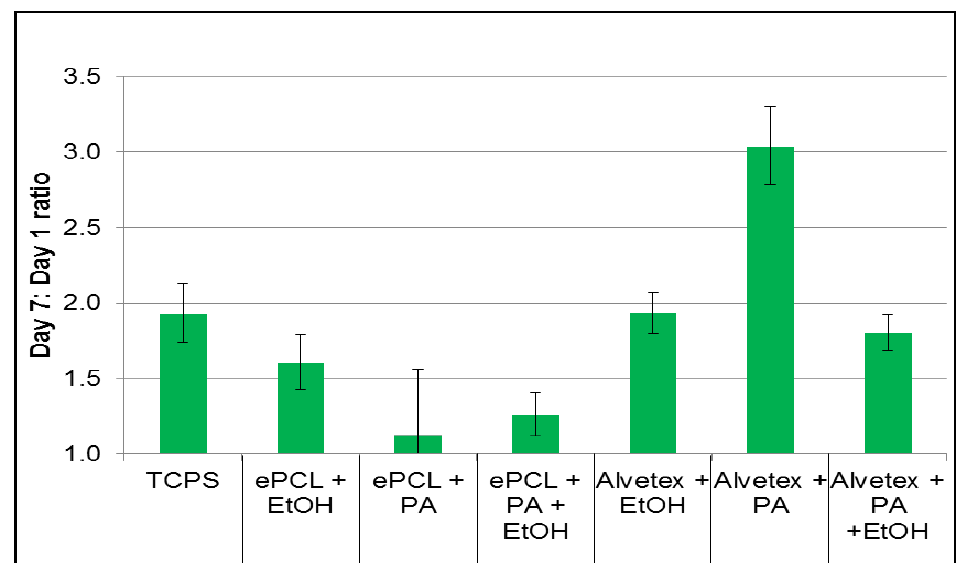
Figure 8. Differential effects of PAA on various substrates. Data is presented as a ratio of optical Figure 8. Di ff erential e ff ects of PAA on various substrates. Data is presented as a ratio of optical densities from day 7 to day 1 to account for significant differences in initial (day 1) cell attachment on densities from day 7 to day 1 to account for significant di ff erences in initial (day 1) cell attachment on different surfaces. Since each scaffold serves as its internal control, this approach allows comparison di ff erent surfaces. Since each sca ff old serves as its internal control, this approach allows comparison of of cell proliferation across scaffolds. While ES+PA+ EtOH supported early cell survival and limited cell proliferation across sca ff olds. While ES + PA + EtOH supported early cell survival and limited cell cell proliferation, it was significantly lower than Ctrl ES. PA+ Alvetex showed maximal cell proliferation, it was significantly lower than Ctrl ES. PA + Alvetex showed maximal cell proliferation, proliferation, which decreased following ethanol wash. which decreased following ethanol